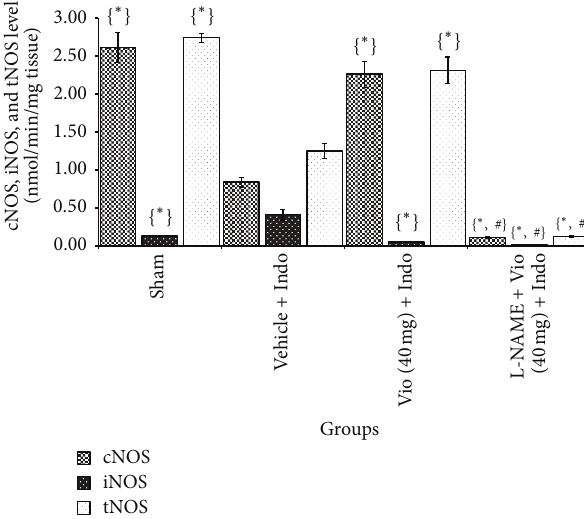
Figure 8: Effect of L-NAME (NOS inhibitor) and violacein (40 mg/kg, orally) on cNOS, tNOS, and iNOS levels in indomethacin-induced ulcerated rats. Values are mean ± SD ( n = 6). ∗ 𝑃 < 0.05 compare vehicle + Indo with all the groups; # 𝑃 < 0.05 compare Vio (40 mg) + Indo with L-NAME + Vio (40 mg) + Indo. Indo: indomethacin; Vio: violacein; L-NAME: N-G- nitro- L-arginine methyl